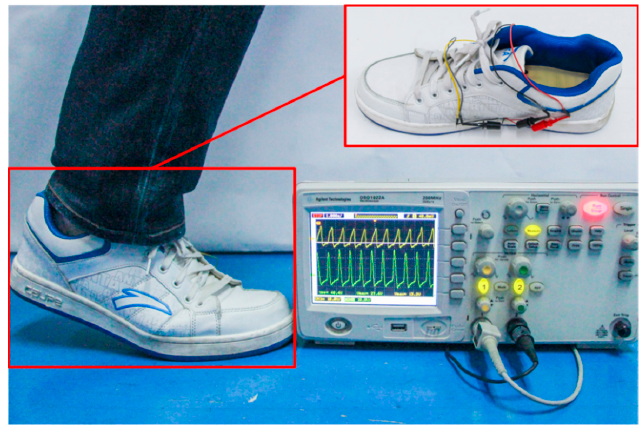
Figure 3. A photograph showing the insole in a shoe directly attached to an oscilloscope to record voltage waveforms generated under foot.